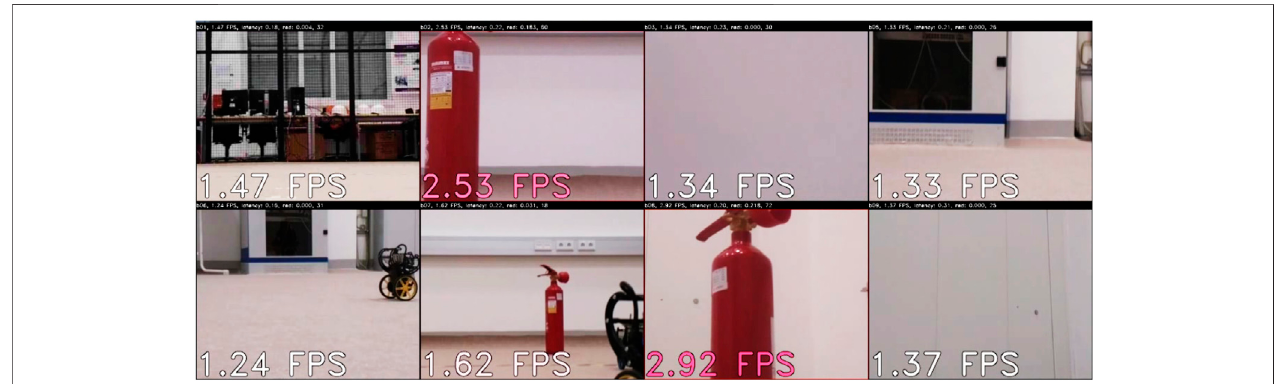
FIGURE 5 | Screenshot of the demonstrator in which the robots are exchanging images and our method maintains a limited throughput constraint while giving preference to images containing more red pixels.